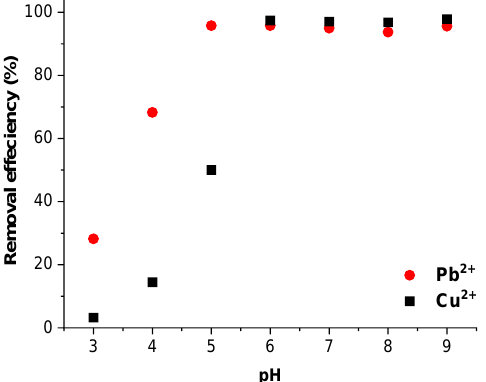
Figure 1. Effect of pH on the removal efficiency of Pb 2+ and Cu 2+ by PAM@MNP. Adsorbent dose: 0.2 g L −1 ; initial Cu 2+ and Pb 2+ concentration: 10 mg L −1 ; temperature: 20 °C; contact time: 24 h.